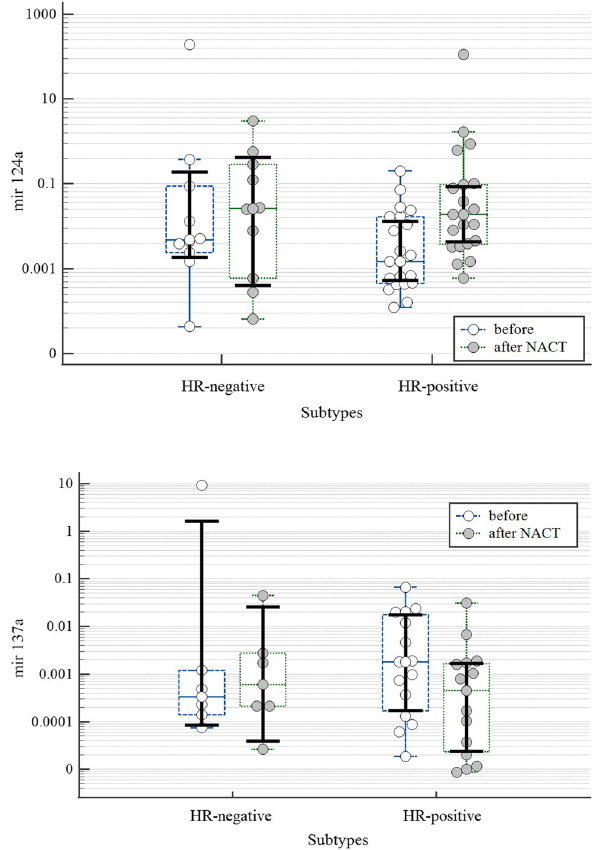
Fig. 2 The expression of miR- 137 in primary cancer tissues differed after treatment of patients with HR-positive BC (p <